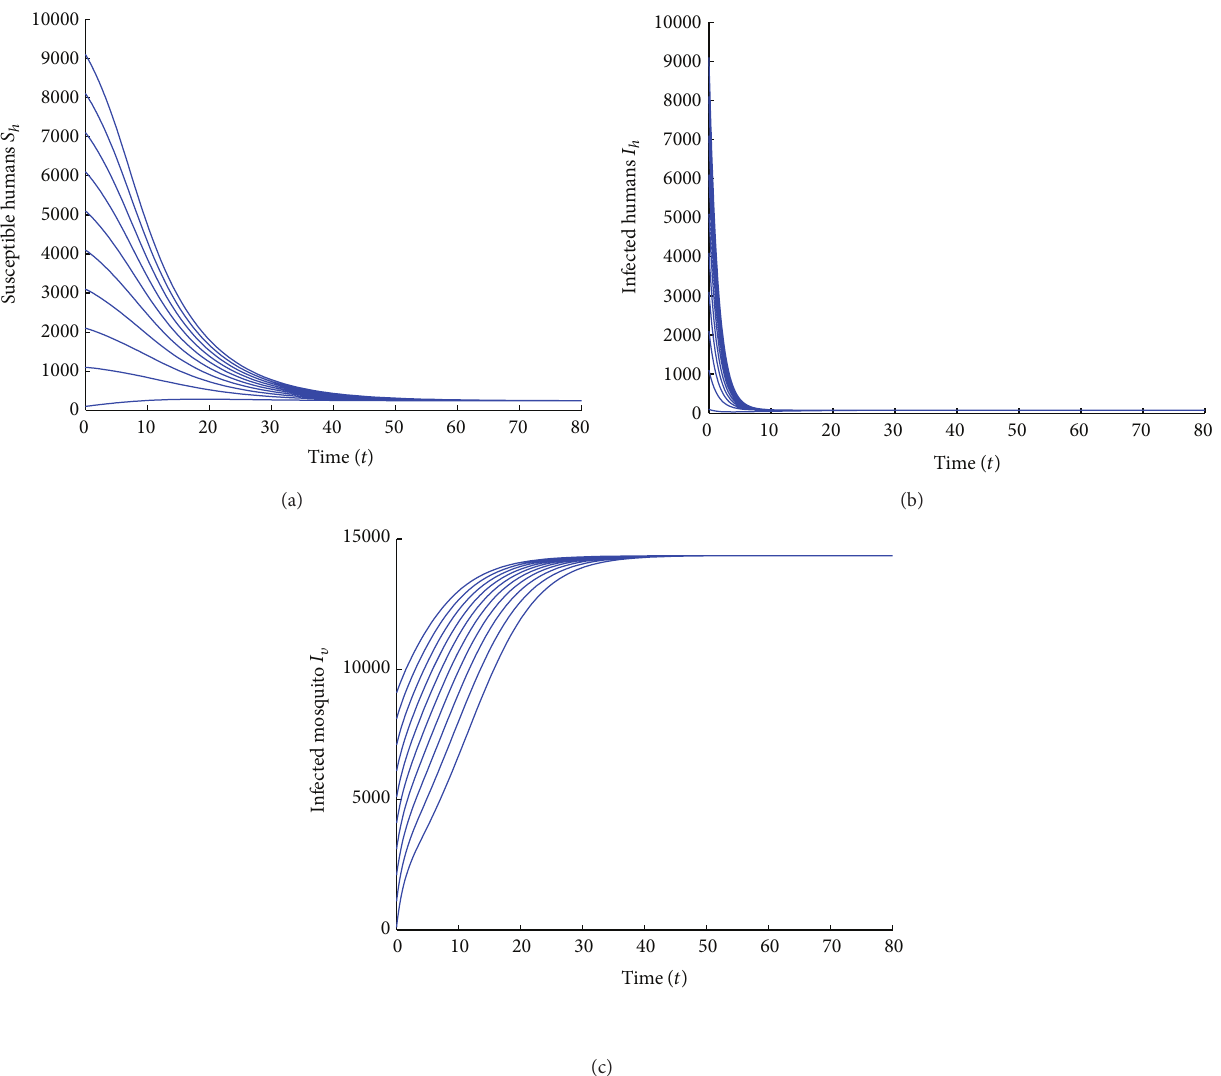
Figure 6: Simulations of the model (5) showing (a) the number of susceptible humans, (b) the number of infected humans, (c) the number of infected mosquitoes, as a function of time using the parameters: 𝑏 = 0.5 , Λ ℎ = 25 , Λ 𝑣 = 500 , 𝛽 1 = 0.00001 , 𝛽 2 = 0.005 , 𝜇 ℎ = 0.03, 𝜇 𝑣 = 0.03 , = 0.0001 , and 𝛾 = 0.6 (so that ℜ = 9.1843 > 1 𝜎 = 0.8 , 𝛿 ℎ ℎ 0